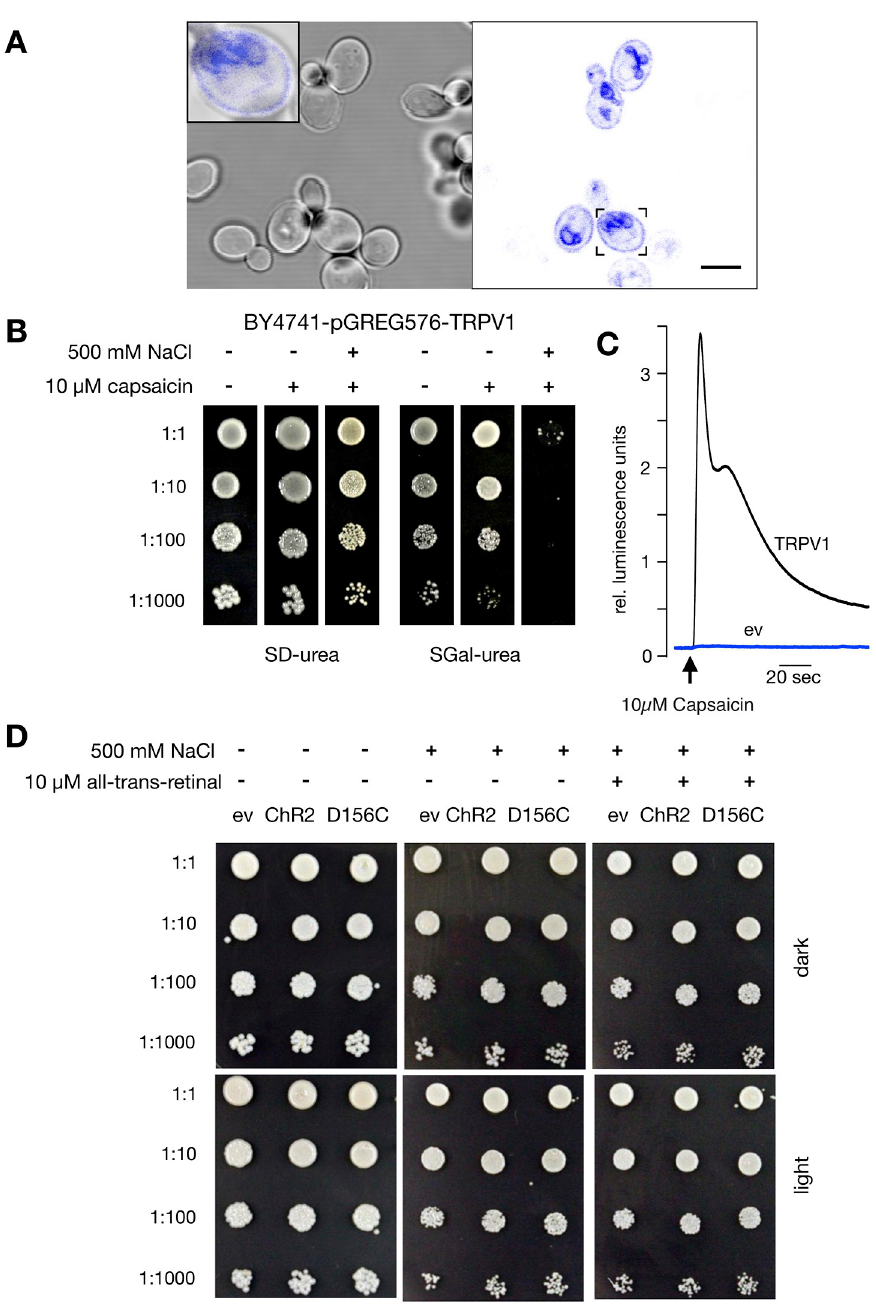
Fig 1. ChR2 is properly expressed in yeast strain BY4741 but shows no sign of function. (A) Confocal images of BY4741 yeast strain in SGal-ura overnight cultures. Transmission images (left) and corresponding fluorescent images (right) of eYFP-tagged ChR2. Inset : Magnification and overlay of transmission and fluorescent images from cell indicated in right panel showing that fluorescence is visible in position of the plasma membrane. (B) Droplet test of BY4741 transformed with the pGREG576 plasmid bearing the ORF for the capsaicin receptor TRPV1 from Rattus norvegicus . In SD-ura, without induction of transcription, the presence of either the channel activator capsaicin, the permeant Na + or both had very little effect on growth (left panel). With induction of transcription by galactose (right panel), channel activation by capsaicin alone had little effect on growth. However, the additional presence of 500 mM NaCl resulted in a strong growth inhibition. (C) Luminometric assay reveals capsaicin triggered calcium influx in BY4741 yeast cells expressing TRPV1, but not in control cells harbouring the empty pGREG576 plasmid. Arrow indicates injection of 10 μ M capsaicin. Curves are the means of 6 recordings for the TRPV1 strain and 2 recordings for the empty vector control. (D). Droplet test of BY4741 transformants without (-) and with (+) 500 mM NaCl salt